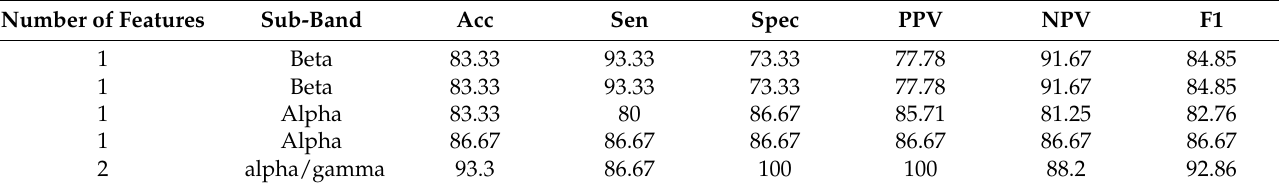
Table 4. The best performance measures of threshold